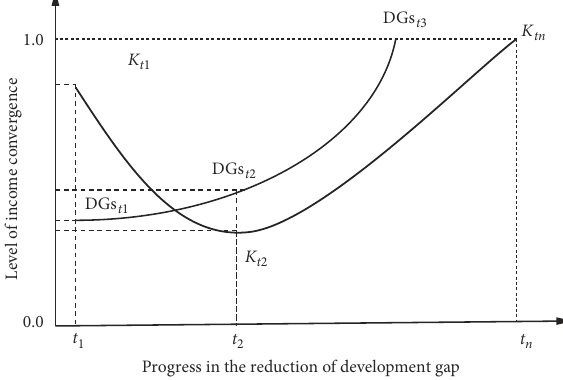
Parameter K determines the level of income convergence for the period [ t; t n ], according to the formula: where: GDP pc Zi – GDP per capita of the backward region in period t i ; GDP pc Ki – average domestic GDP per capita in period t i . Figure 2. The relationship between the level of income convergence and the scale of development gap